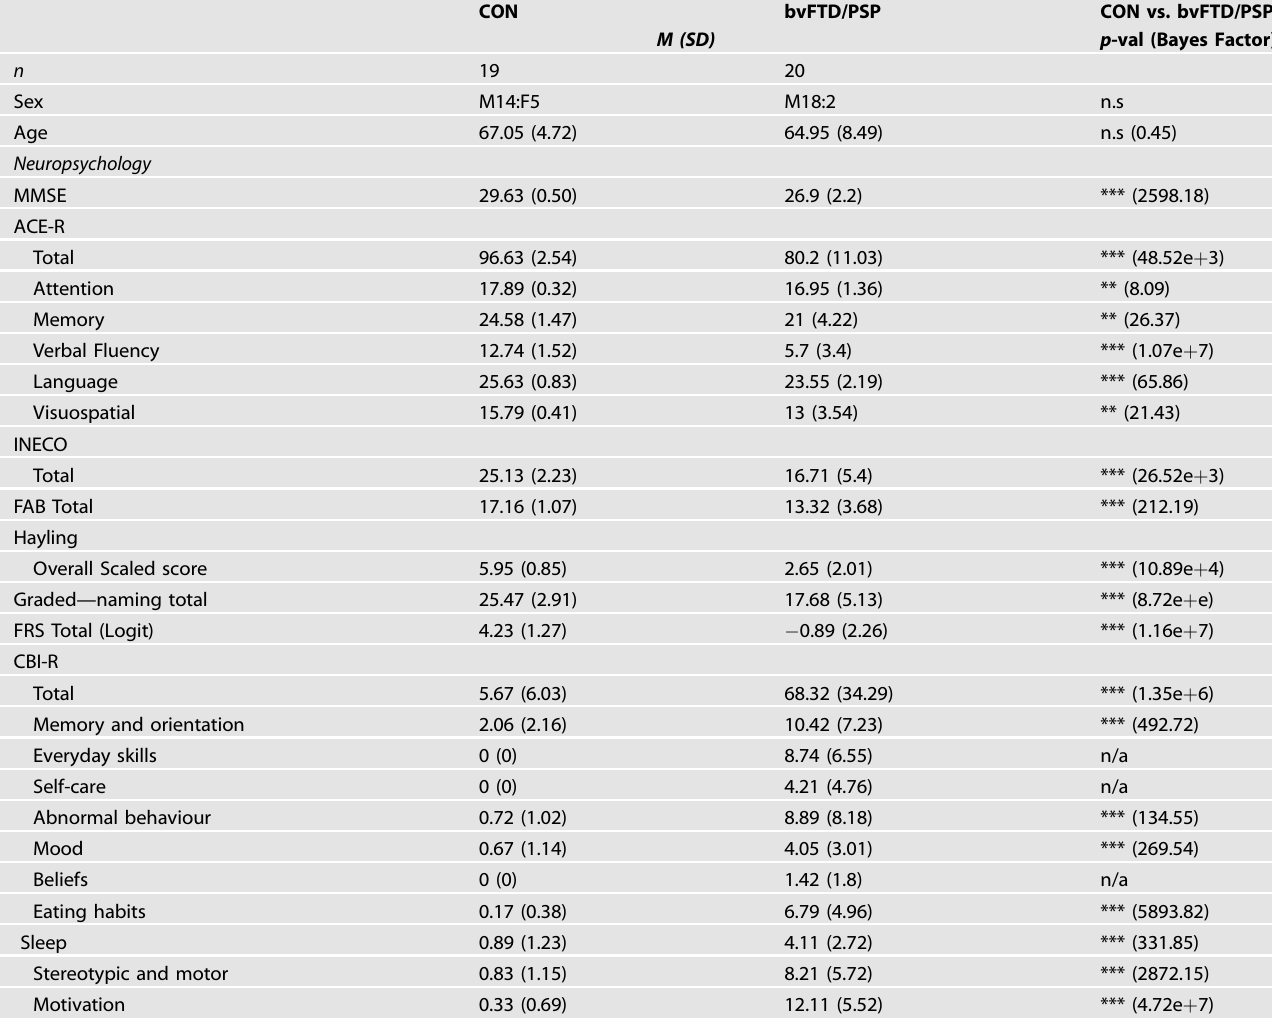
Table 1. Demographic and neuropsychological information of study